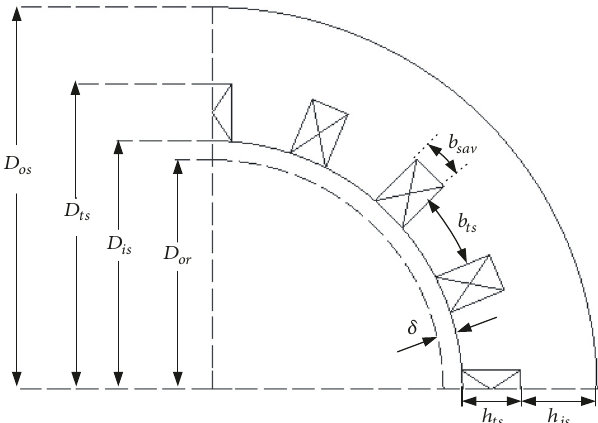
Figure 1: Stator structure of permanent magnet motor for